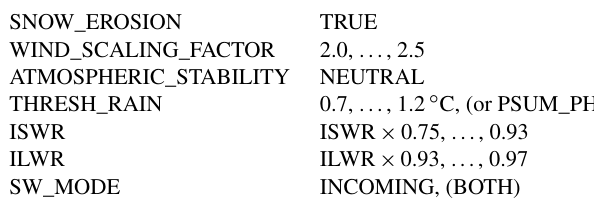
Table 3. Most relevant settings for SNOWPACK which produced the best